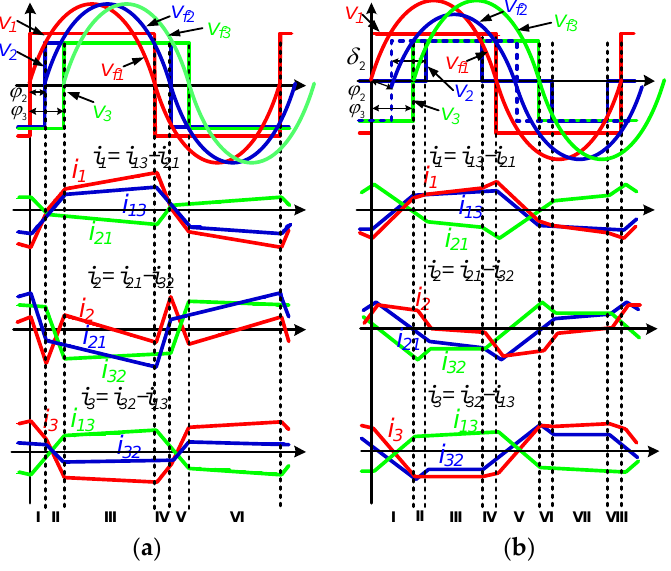
Figure 7. Idealized steady-state waveforms under isolation control. ( a ) Single phase shift (SPS) control; ( b ) Dual phase shift (DPS) control.